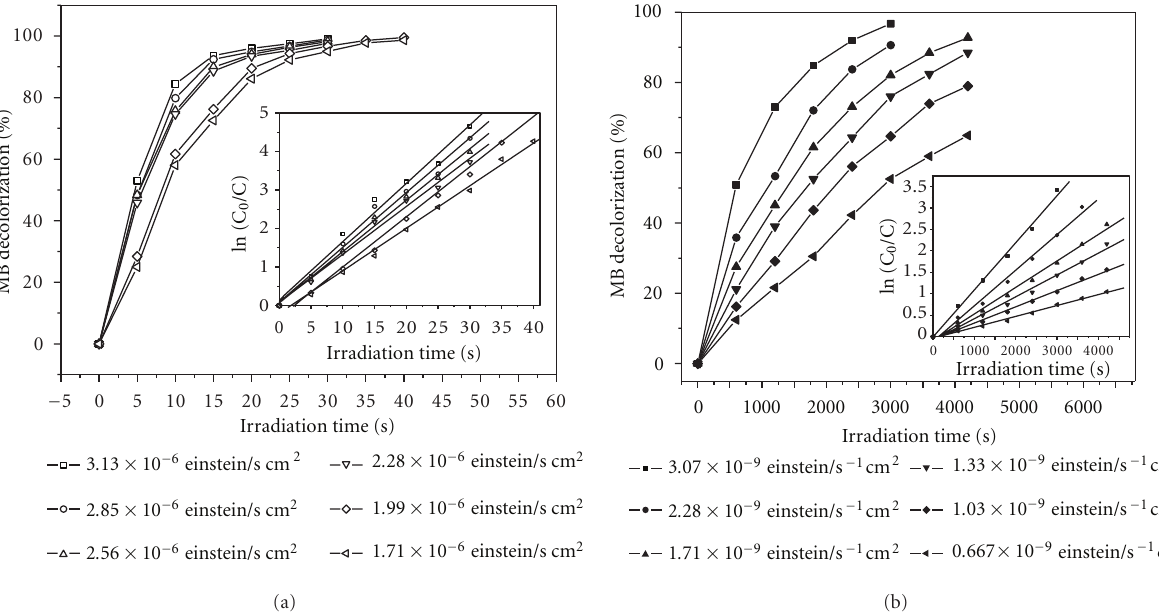
Figure 3: Photocatalytic decolorization of MB versus irradiation time by (a) HUP and (b) LUP. (Experimental conditions: TiO 2 , 1gL − 1 ; MB initial concentration 20mg L − 1 ).